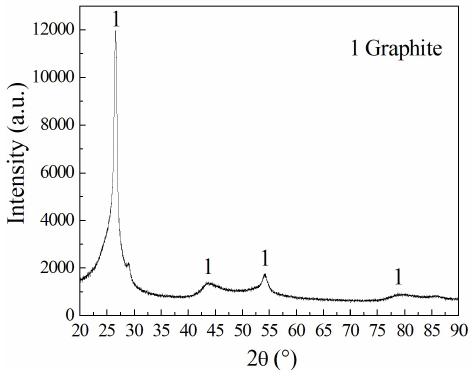
Figure 9. XRD pattern of oxyacetylene ablated surface of C/C composite